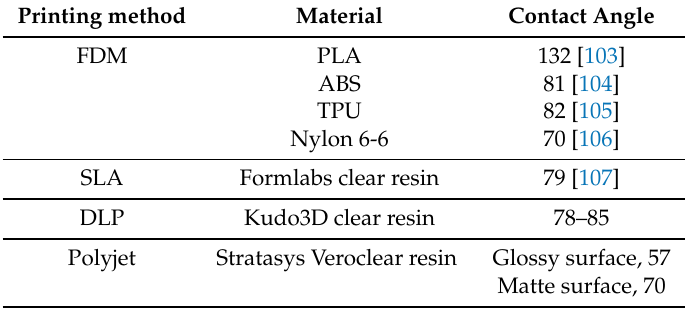
Table 3. Surface wettability of some printing materials used for fabrication of droplet microfluidic